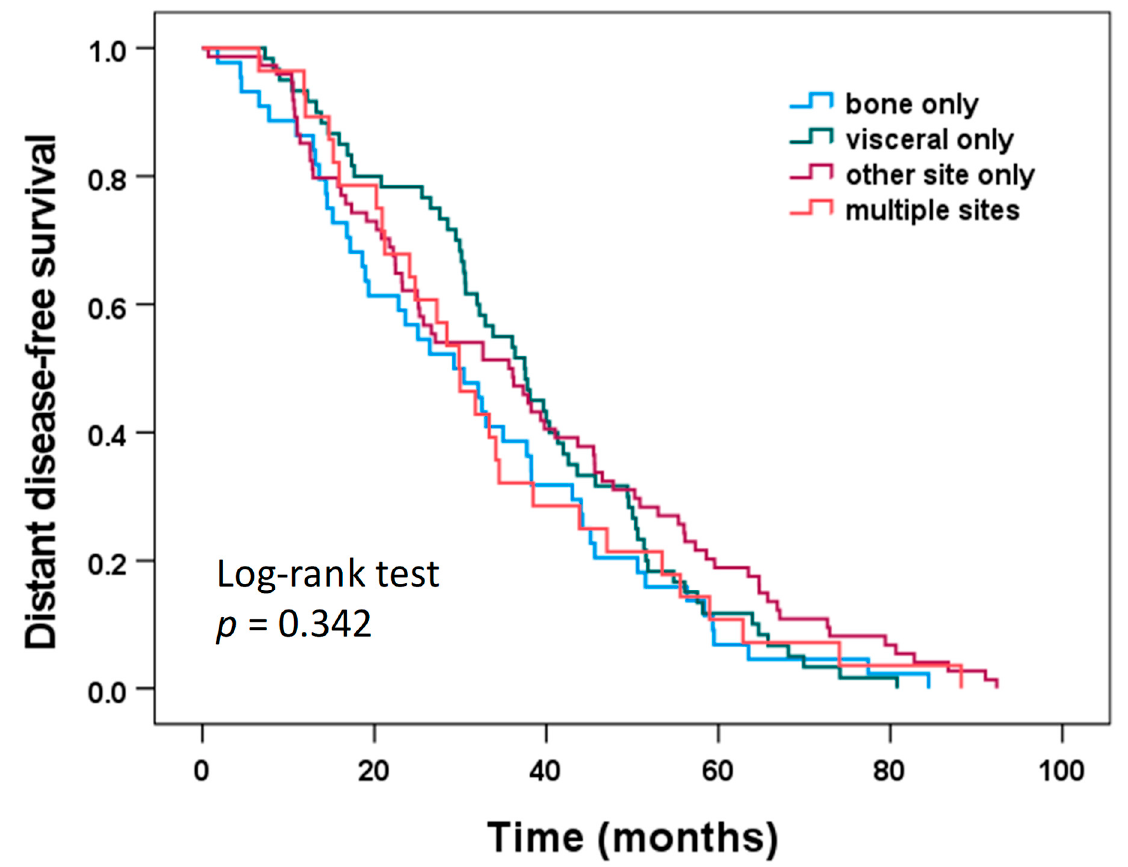
Figure 1. Distant disease-free survival according to the site of first metastatic disease. Overall survival according to the location of first metastatic disease is shown in Figure 2. Patients with first metastatic disease at multiple sites had significantly shorter OS (median 42.0 months) compared to patients with bone-only first metastatic disease (median 68.7 months; log-rank test pairwise comparison: p = 0.014), patients with visceral-only first metastatic disease (median 63.6 months; log-rank test pairwise comparison: p = 0.016), and patients with first metastatic disease at other sites only (median 67.5 months; log-rank test pairwise comparison: p = 0.003). No significant differences with regard to OS were found between patients with bone-only, visceral only, and other site only first metastatic disease (log-rank test pairwise comparisons: all p >